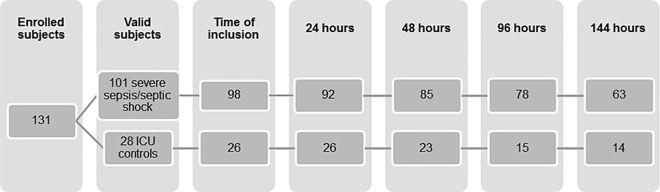
Plasma samples available for analysis over the course of the study.Day of inclusion: Sepsis cohort; 3 missed samples. ICU controls; 2 missed samples. At 24 hours: Sepsis cohort; 4 dead, 4 transferred to other ICU:s and 1 discontinued the study. ICU controls; 1 dead, 1 transferred to another ICU. At 48 hours: Sepsis cohort; 3 transferred to other ICU:s and 4 missed samples. ICU controls; 1 dead, 1 transferred to another ICU and 1 missed sample. At 96 hours: Sepsis cohort; 4 dead, 2 transferred to other ICUs, 2 discontinued and 4 missed samples. ICU controls; 5 dead patients and 5 missed samples. 144 hours: Sepsis cohort; 1 dead, 1 transferred to another ICU, 3 discontinued the study, 4 were discharged from the ICU and 8 missed samples. ICU control; 2 dead patients and 3 missed samples.